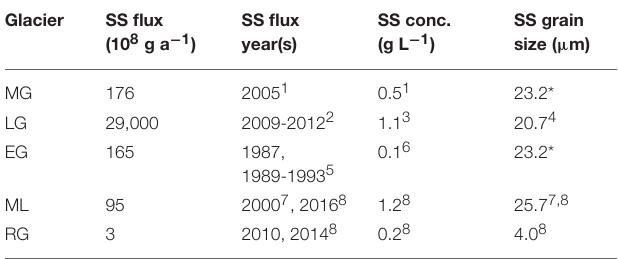
TABLE 3 | Suspended sediment (SS) flux, average concentration and average grain size in meltwater for each glacier catchment.